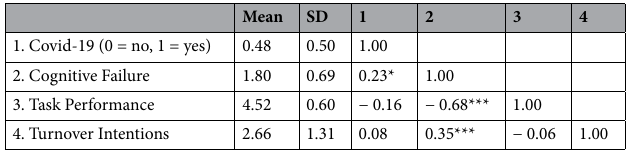
Table 3. Means, standard deviations, and intercorrelations between latent variables. N = 94. *p < 0.05, ***p < 0.001.